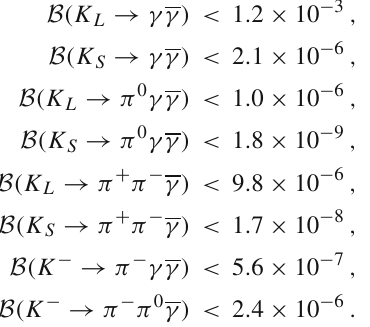
on the branching fractions of yet-unobserved decays of these hadrons deduced from the numbers in the second column, as explained in